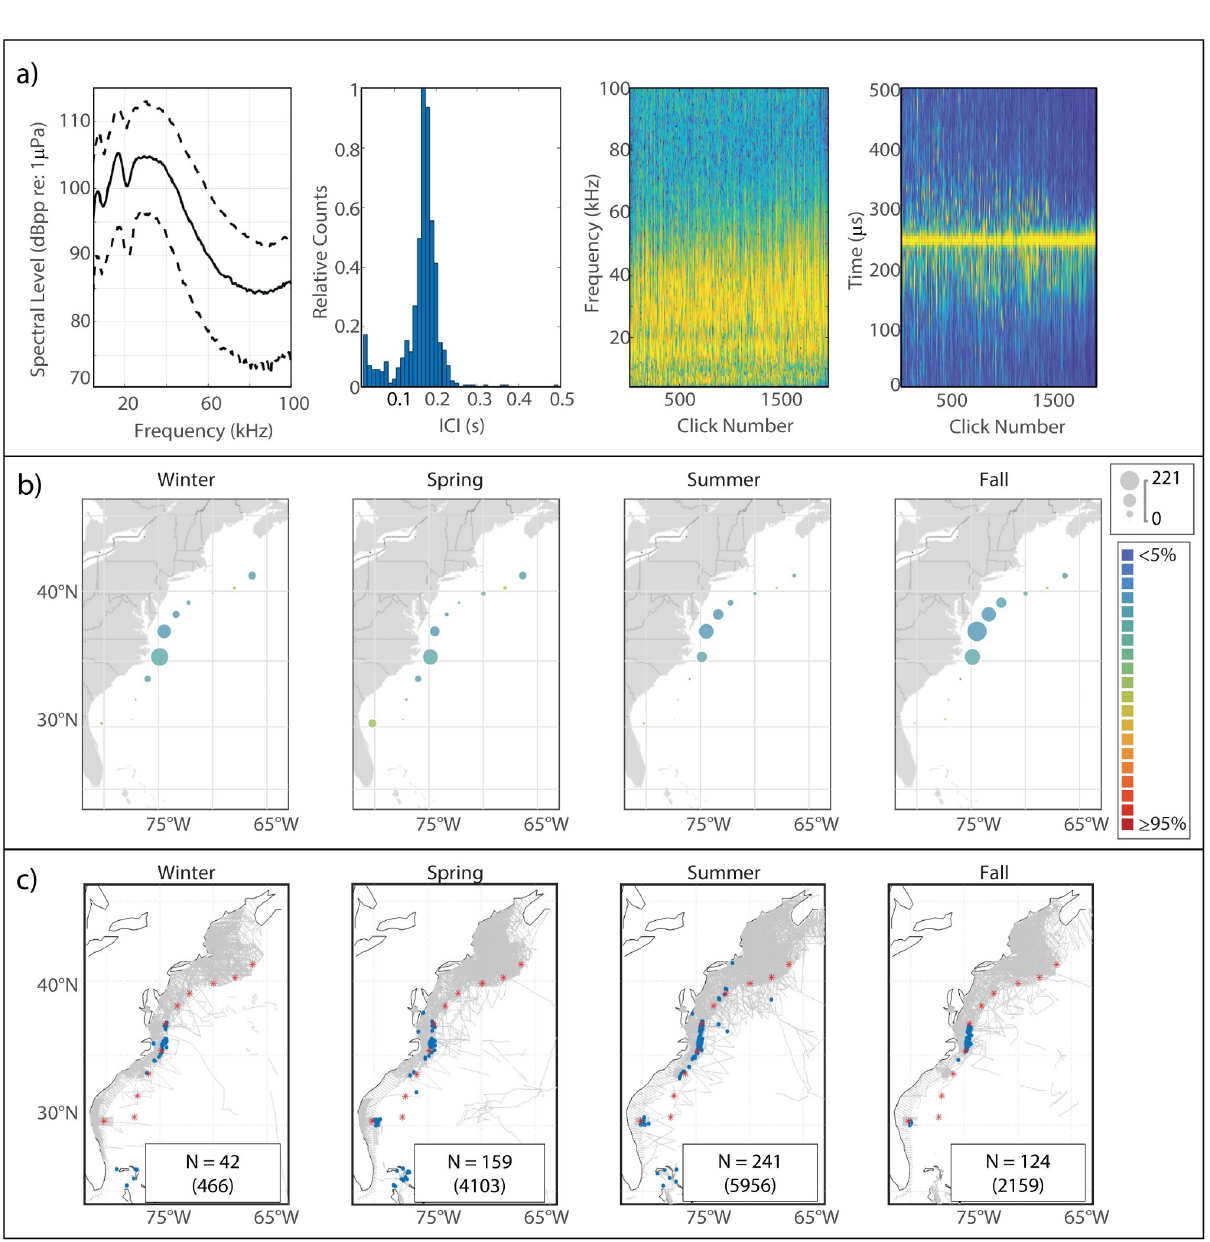
Fig 11. Results for UD26 showing click type (a), acoustic presence (b), and historical sightings of probable species match, short-finned pilot whales (c). Subplots as in Fig